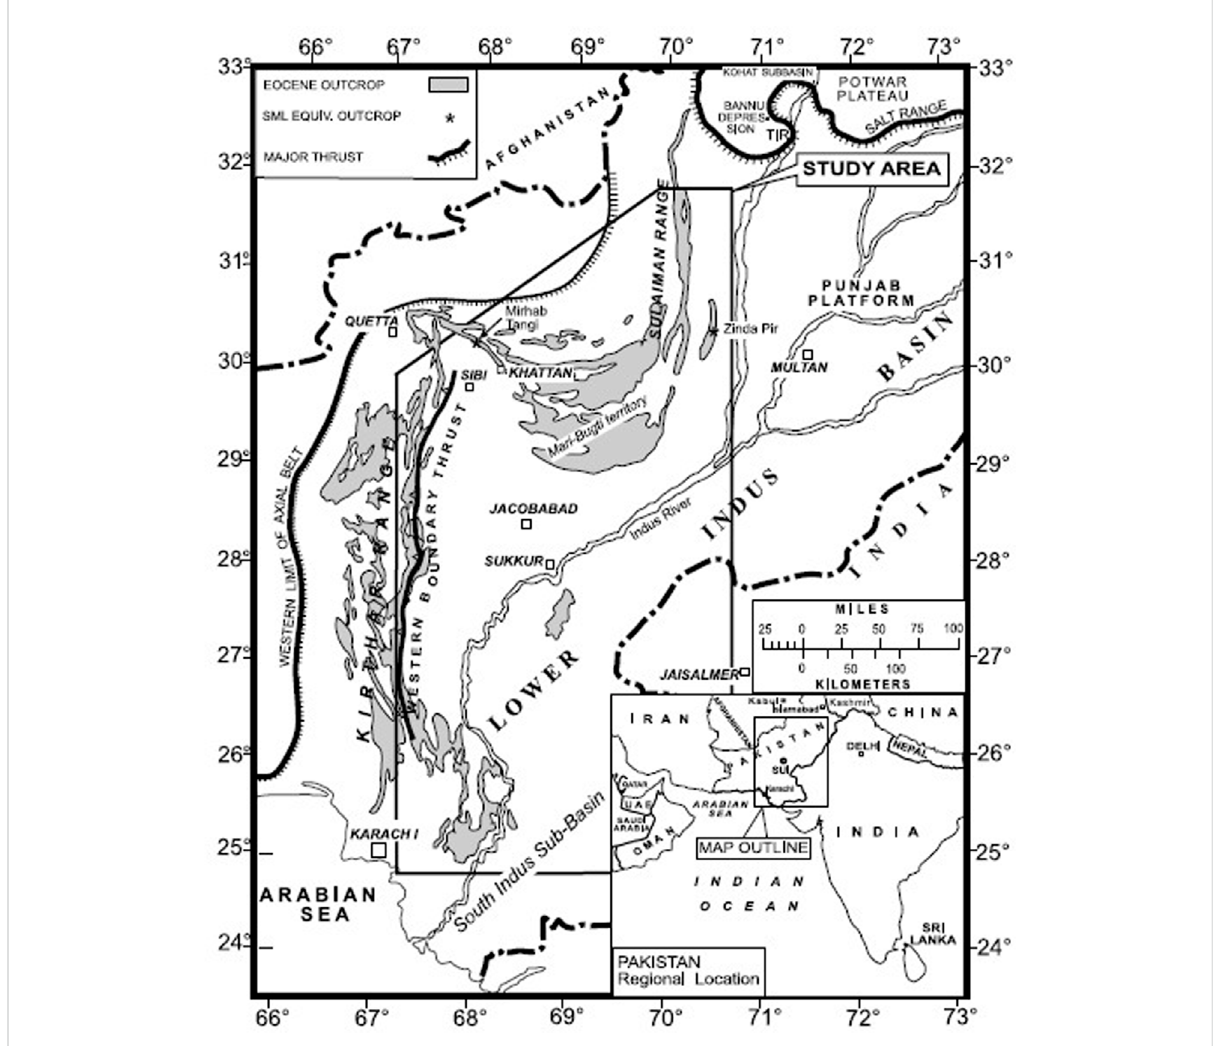
FIGURE 1 Location map of the study area in regional context along with major tectonic distribution of Pakistan (Siddiqui 2004).